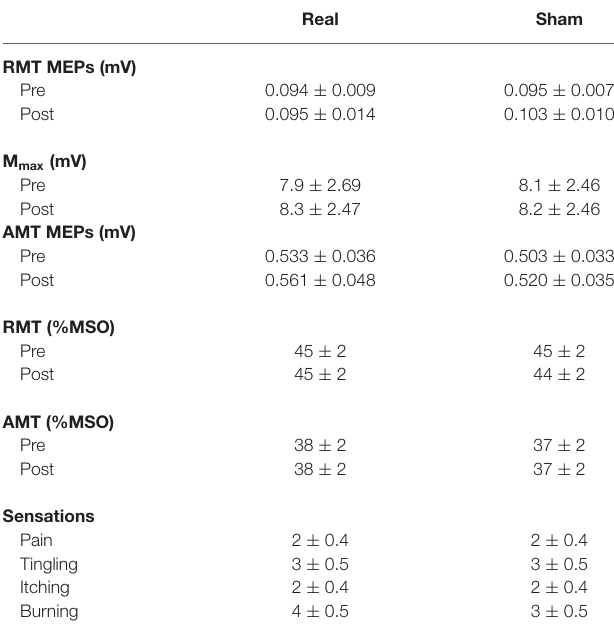
Frontiers in Human Neuroscience |